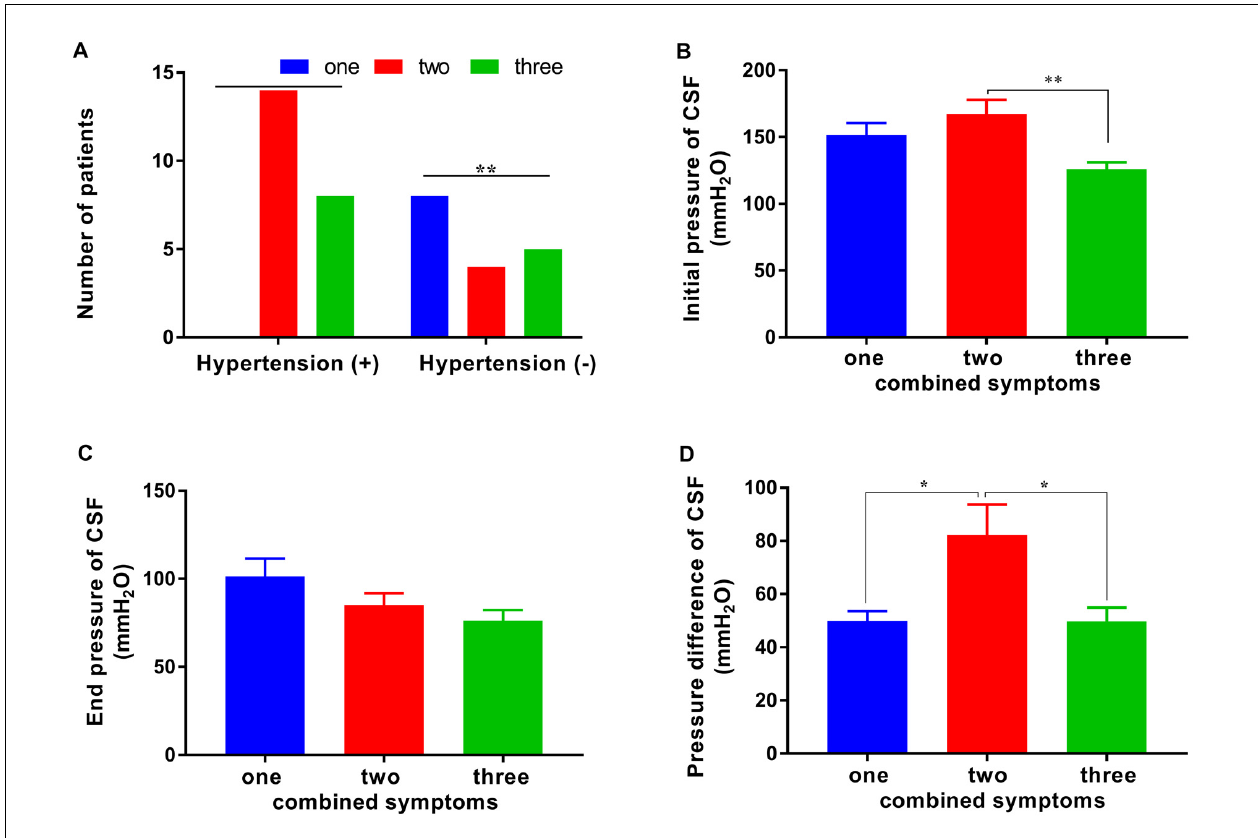
FIGURE 4 | The distribution of combined symptoms and the correlated factors. (A) The distribution of hypertension in patients with one/two/three combined symptoms. (B–D) The CSF initial pressure, end pressure and, pressure difference in patients with one/two/three combined symptoms (* p < 0.05 and ** p < 0.01 compared with the corresponding